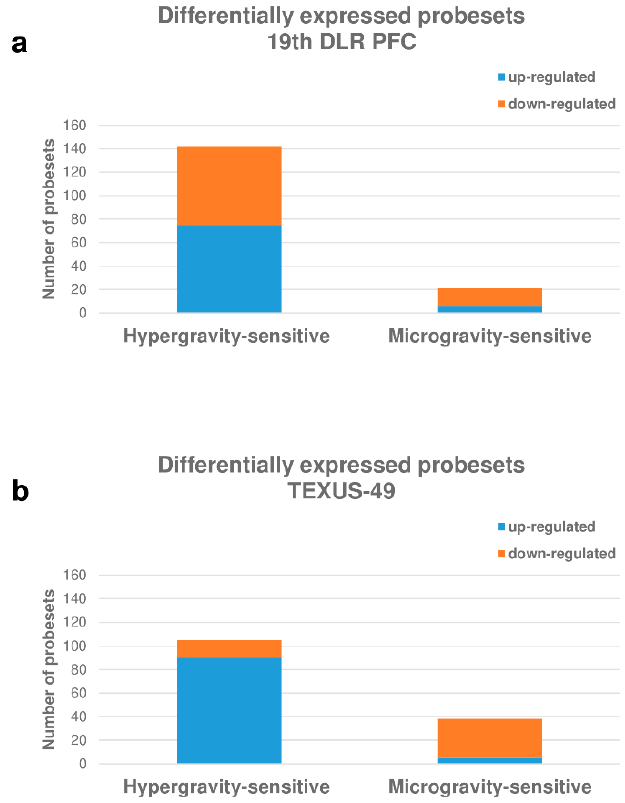
Figure 11. Distribution of differentially expressed probe sets representing HIF-related genes in human U937 cells. ( a ) Hyper- and microgravity-sensitive probe sets (10 − 2 –10 − 3 g/1.8 g) identified in the 19th DLR Parabolic Flight Campaign, ( b ) hyper- and microgravity sensitive probe sets (10 − 4 g/5–7 g) identified in the TEXUS-49 suborbital ballistic rocket campaign.